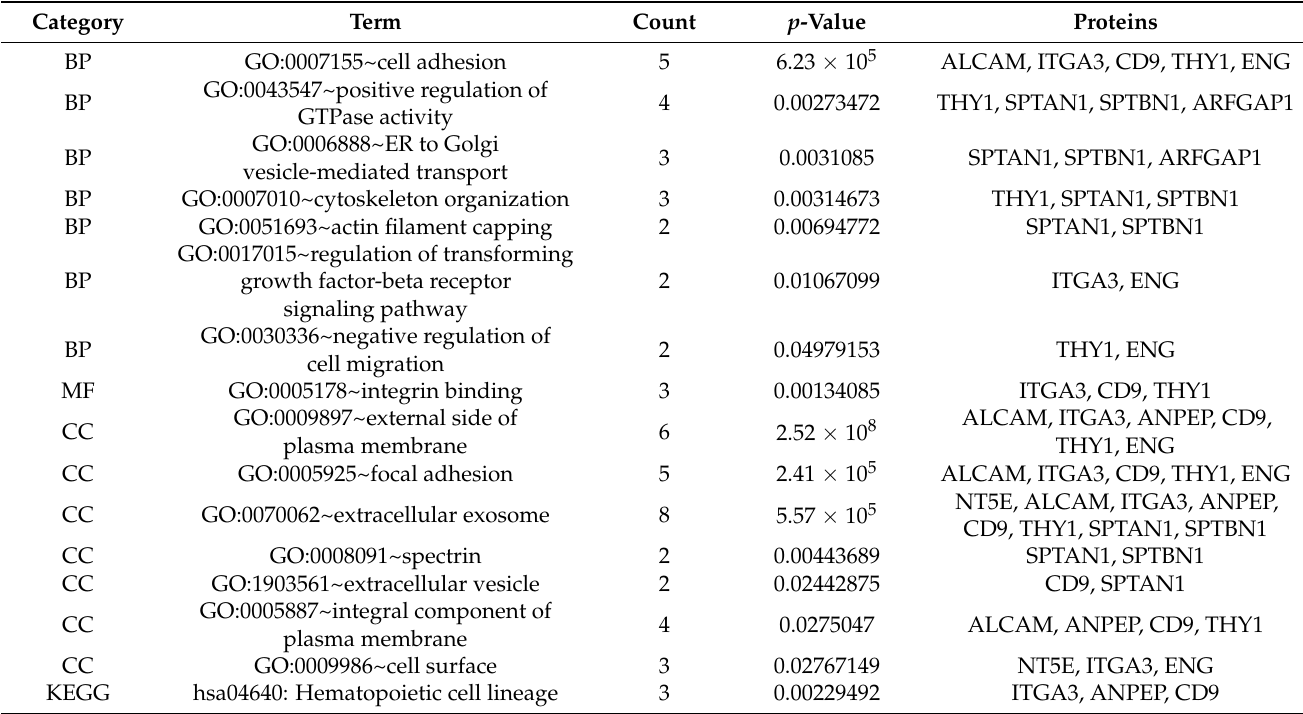
Table 1. GO and KEGG analysis of the 10 hub